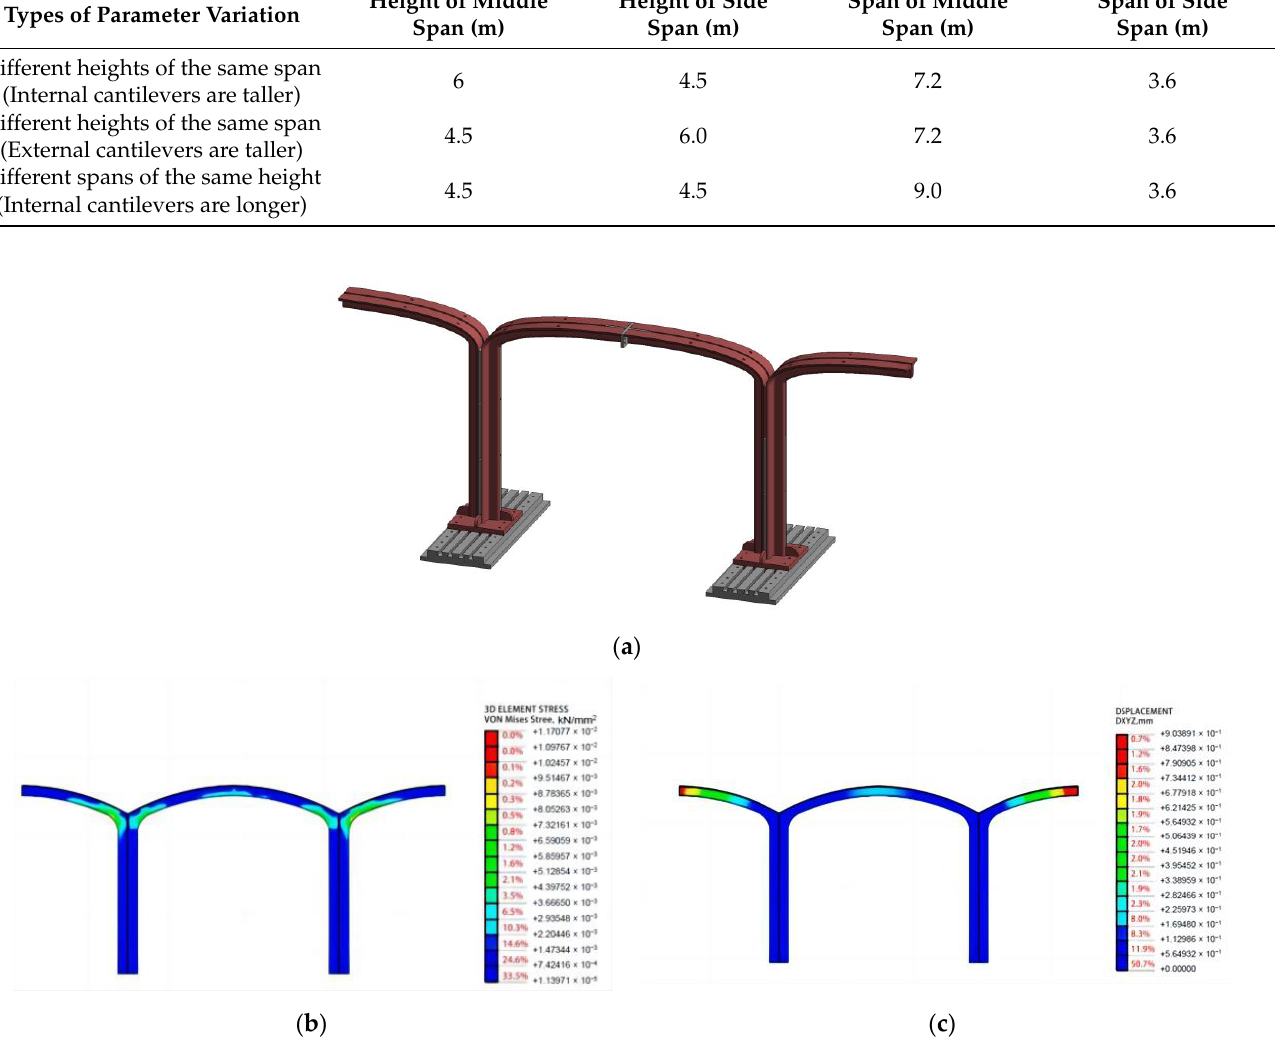
Figure 11. Schematic diagram and mechanical analysis of a single steel frame formed by two standard units and connected by a steel plate. ( a ) Schematic diagram; ( b ) Stress distribution under the vertical load; ( c ) Deformation under the vertical load.